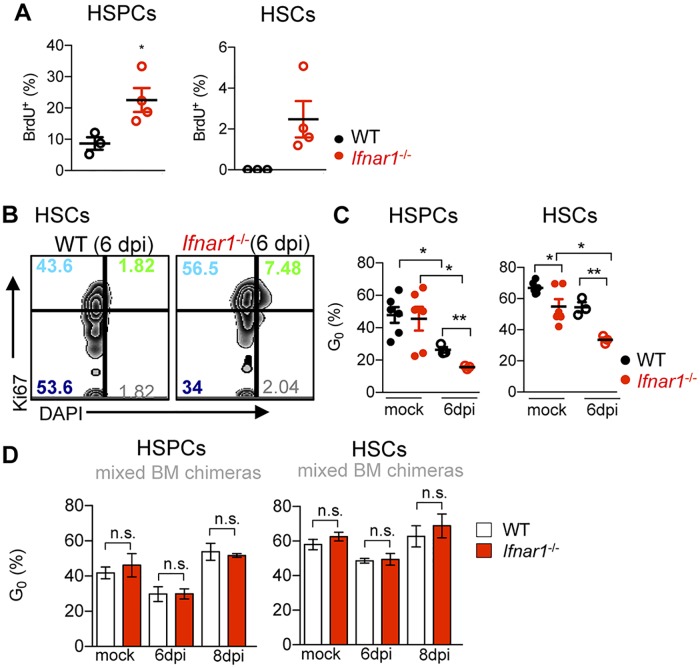
IFNα/β impair infection-induced proliferation of HSCs and HSPCs and indirectly restrict cycling.(A) 4-hour BrdU incorporation by HSPCs and HSCs in IOE-infected WT and Ifnar1-/- mice 7 d.p.i. (B) Representative plots of Ki67 and DAPI staining, gated on HSCs from infected WT and Ifnar1-/- mice 6 d.p.i. Numbers indicate quadrant percentages. (C) Percent cells in G0 among HSPCs and HSCs in mock and IOE-infected WT and Ifnar1-/- mice 6 d.p.i. (D) The percent of WT and Ifnar1-/- cells in G0 in mock- or IOE-infected WT: Ifnar1-/- chimeric mice (as described in Fig 2D) at 6 and 8 d.p.i. *P < 0.05, **P < 0.001.